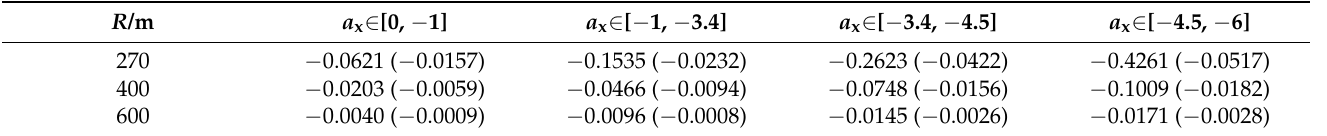
Table 4. Marginal effect of braking manipulation *.